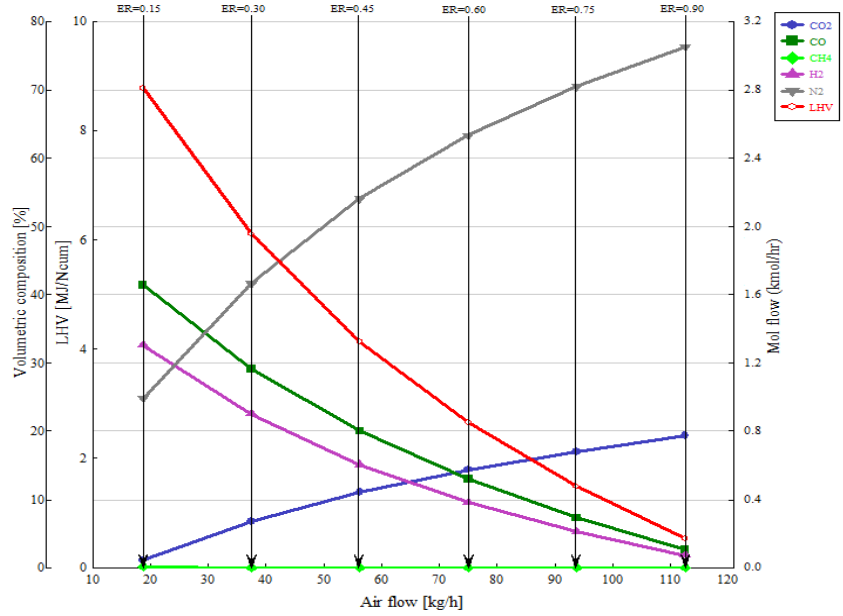
Figure 4. Composition and LHV behavior of the syngas as a function of airflow and ER.